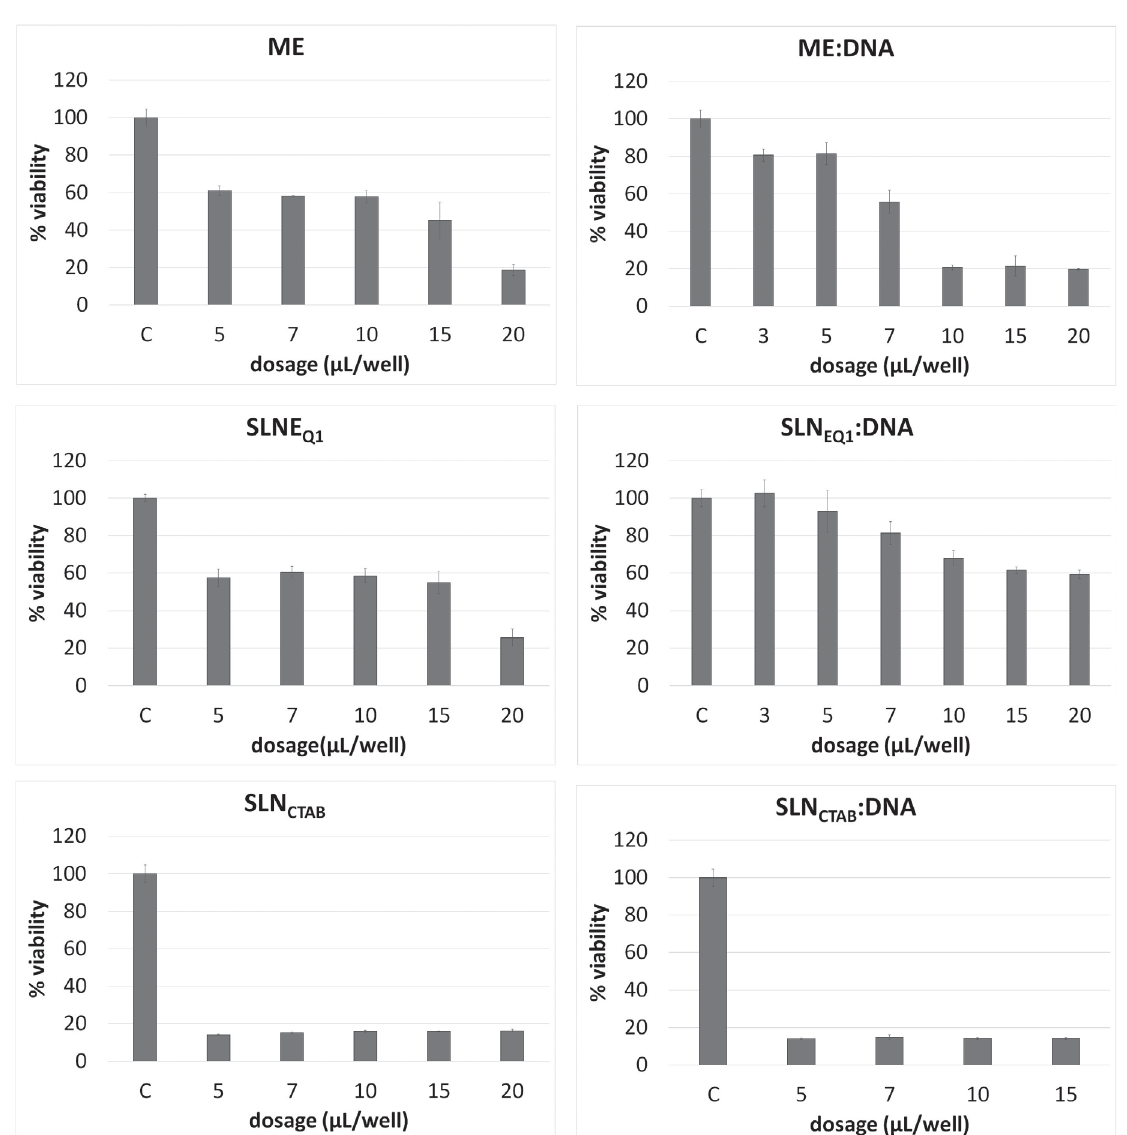
FIGURE 6 - Cell viability after treatment with formulations at different